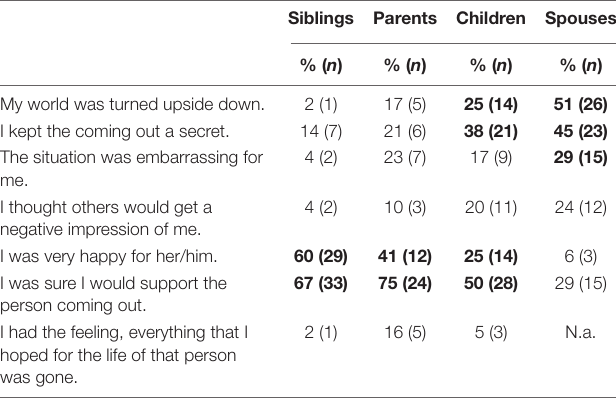
TABLE 4 | Affirmation of statements about thoughts right after the coming